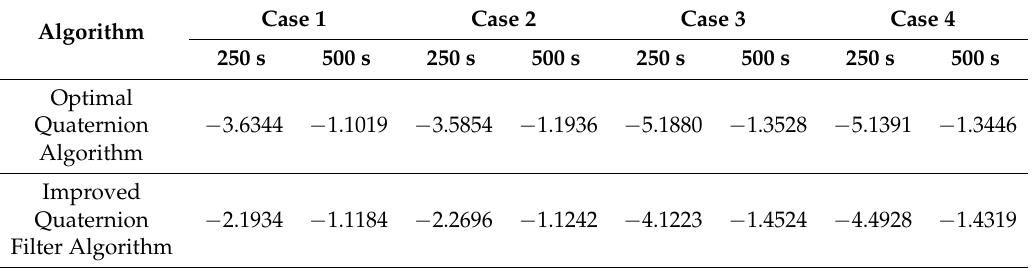
Figure 12. Alignment error curves with different random errors. ( a ) The error curves of pitch angle; Figure 13. Alignment error curves of two algorithms. ( a ) The error curves of pitch angle; ( b ) the error ( b ) the error curves of roll angle; ( c ) the error curves of heading angle. curves of roll angle; ( c ) the error curves of heading angle. Table 4. Heading angle errors of two algorithms ( ◦